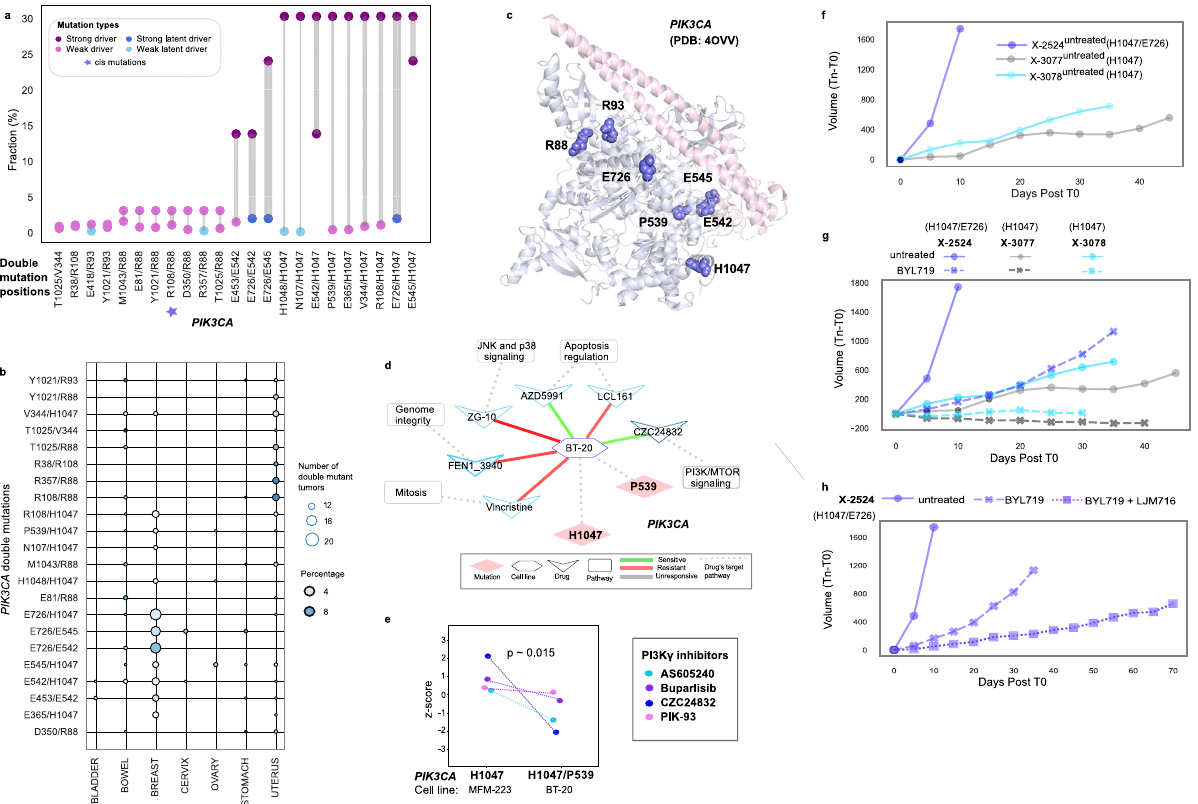
Fig. 3 A detailed analysis of PIK3CA double mutation pro fi le, 3D structure, and clinical implications. a Paired dot plot of the 23 double mutations in PIK3CA , and the number of tumors carrying them. Colors indicate type of a mutation, strong driver (purple), weak driver (orchid), strong latent driver (blue), and weak latent driver (sky blue). Line sizes connecting the dots are proportional to the number of tumors with double mutations. b Presence of PIK3CA same gene double mutations across different cancer tissues. Dots are scaled based on the number of tumors having double mutations, and color corresponds to the percentage of double mutant tumors among single mutants. c 3D structure of PIK3CA (PDB: 4OVV) with H1047, E726, E542, E545, R88, R93, and P539 mutations. d Response of PIK3CA breast cancer cell line BT-20 with double mutations in cis to drugs in network representation. Dashed lines connecting cell line nodes (hexagon) to mutation nodes (diamond) indicates that the cell line harbor the corresponding mutations. Green and red lines connecting cell line nodes (hexagon) to drug nodes (V-shaped) represent sensitivity and resistance of the cell line to the corresponding drugs, respectively. Dashed lines between the drug nodes (V-shaped) and pathway nodes (rectangle) indicate that the drugs have target(s) in the corresponding pathways. e PIK3CA mutation doublets in breast cancer and the associated violin plot illustrating response to PI3K ɣ inhibitors. f Tumor volume changes of single and double PIK3CA mutant xenografts without any treatment. g Tumor volume comparison of the single and double mutant xenografts without any treatment and with BYL719 (Alpelisib) treatment. h Comparing tumor volume changes of the double PIK3CA mutant xenografts without any treatment and with BYL719 and BYL719 + LJM716